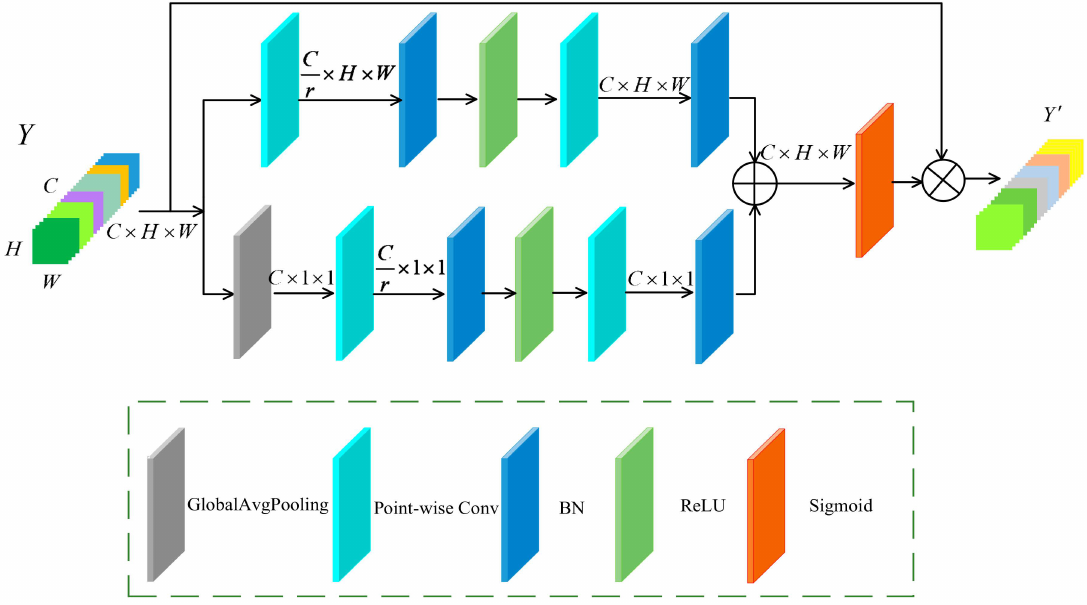
Figure 4. Schematic diagram of 3D-MSSAM.